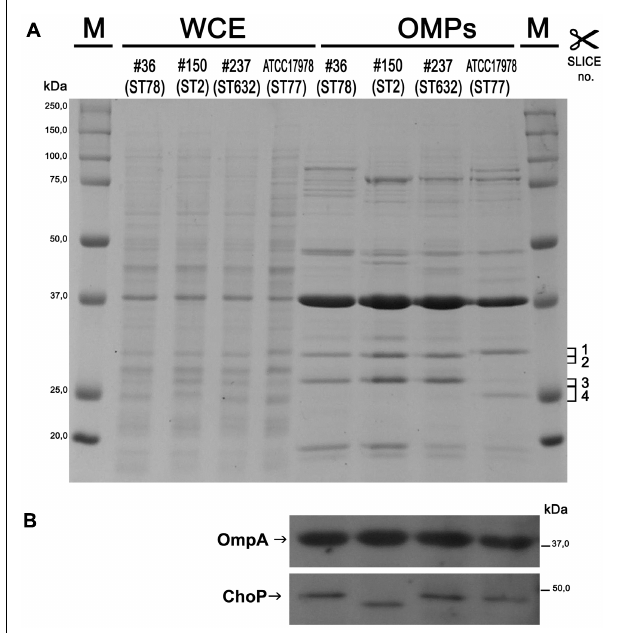
FIGURE 1 | Protein profiles and analysis of the outer membrane (OM) fractions from carbapenem-resistant Acinetobacter baumannii (CRAb). Proteins present in WCEs and in the outer membrane protein (OMP) fractions were stained with Coomassie brilliant blue (A) or transferred to a PVDF membrane and probed using anti-OmpA and anti-ChoP TEPC 15 antibodies (B) . Size markers (kDa), the four gel slices excised and subjected to in-gel digestion (complete data are presented in Supplementary Table S2) and the positions and names of OmpA and ChoP are